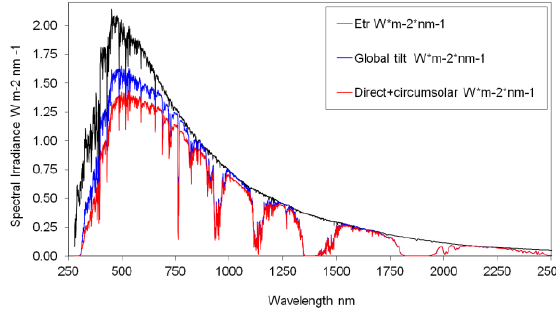
Fig. 2. Solar ASTM G173-03 Reference Spectra